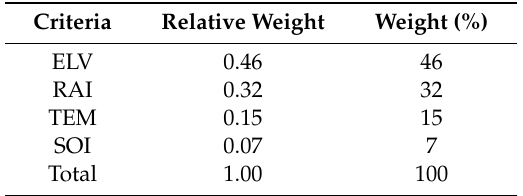
Table 8. Weights of the four criteria of the AZ analysis using the AHP.